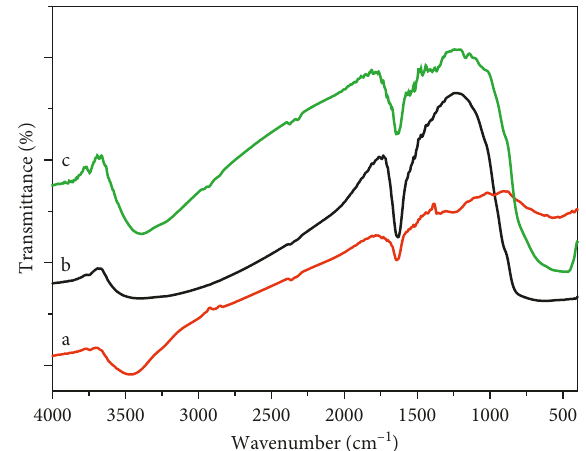
Figure 4: FTIR spectra of GO (a), TiO (c)